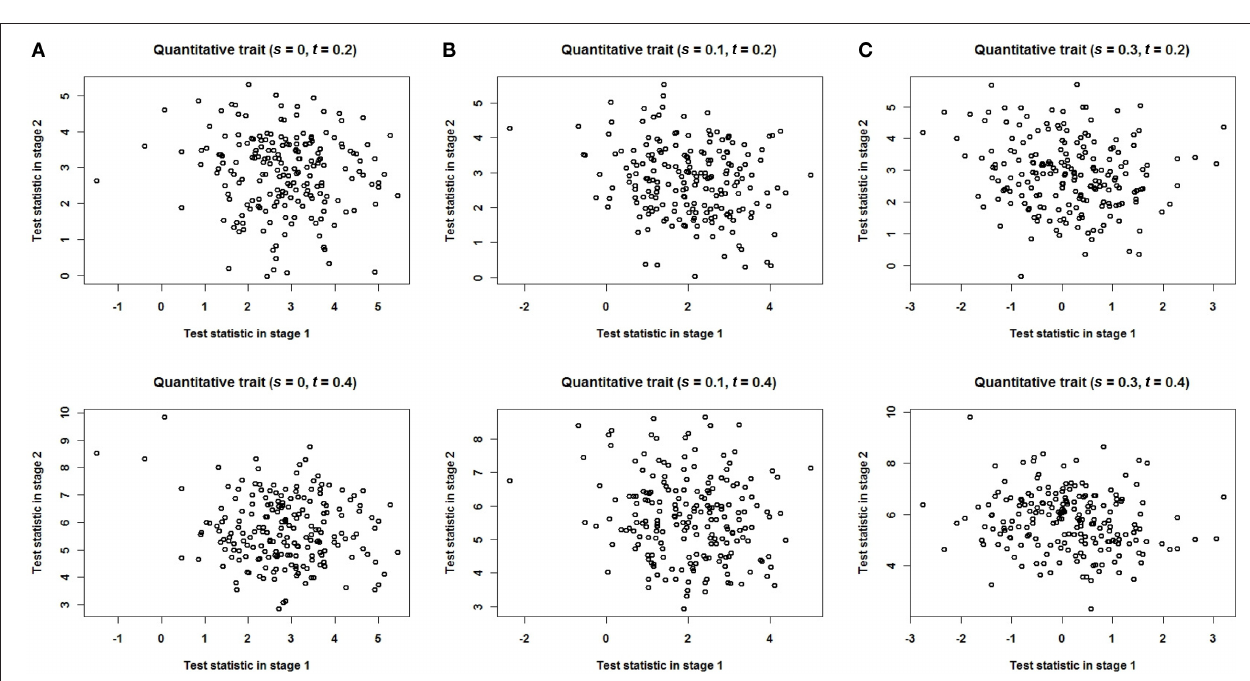
FiGure A2 | scatter plot of the test statistics in stage 2 versus the test statistics in stage 1 in the two-stage procedure under the alternative. (A) is for s = 0; (B) is for s = 0.1 and (C) is for s = 0.3. t = 0.2 and 0.4.